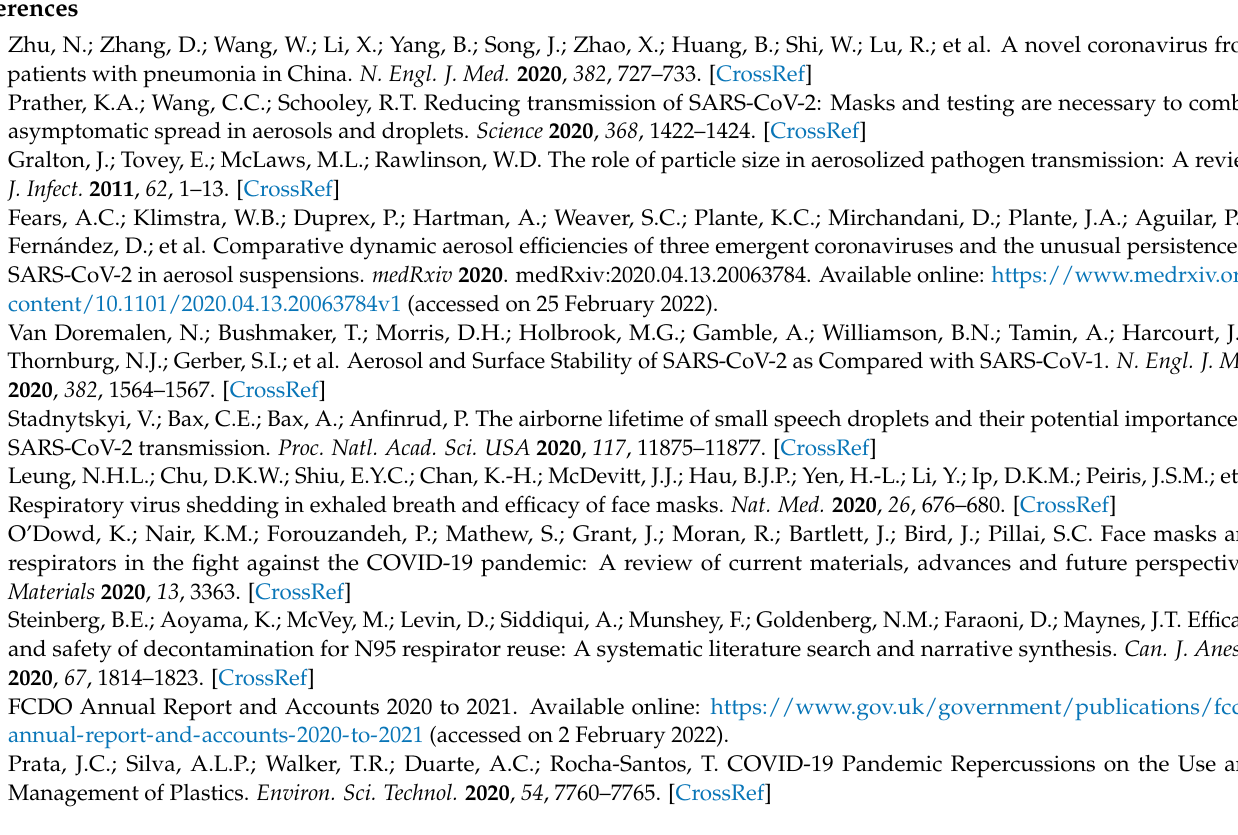
figuration for BFE analysis; Figure S2: Evaluation of Bacterial Filtration efficiency (BFE) (%) and Breathability (BRE) (Pa/cm 2 ) after one cycle of water immersion at 40 ◦ C; Table S1: Cut-point sizes of the Andersen